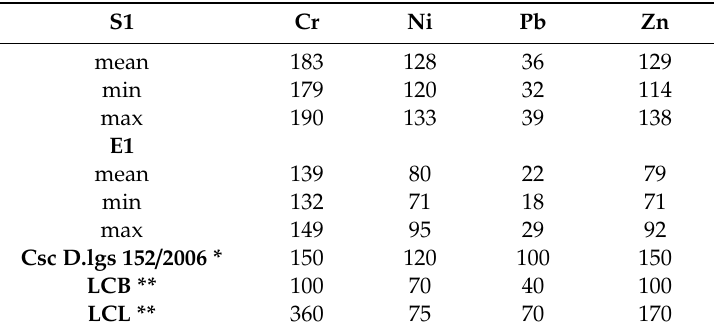
Table 4. Mean metal concentrations (this